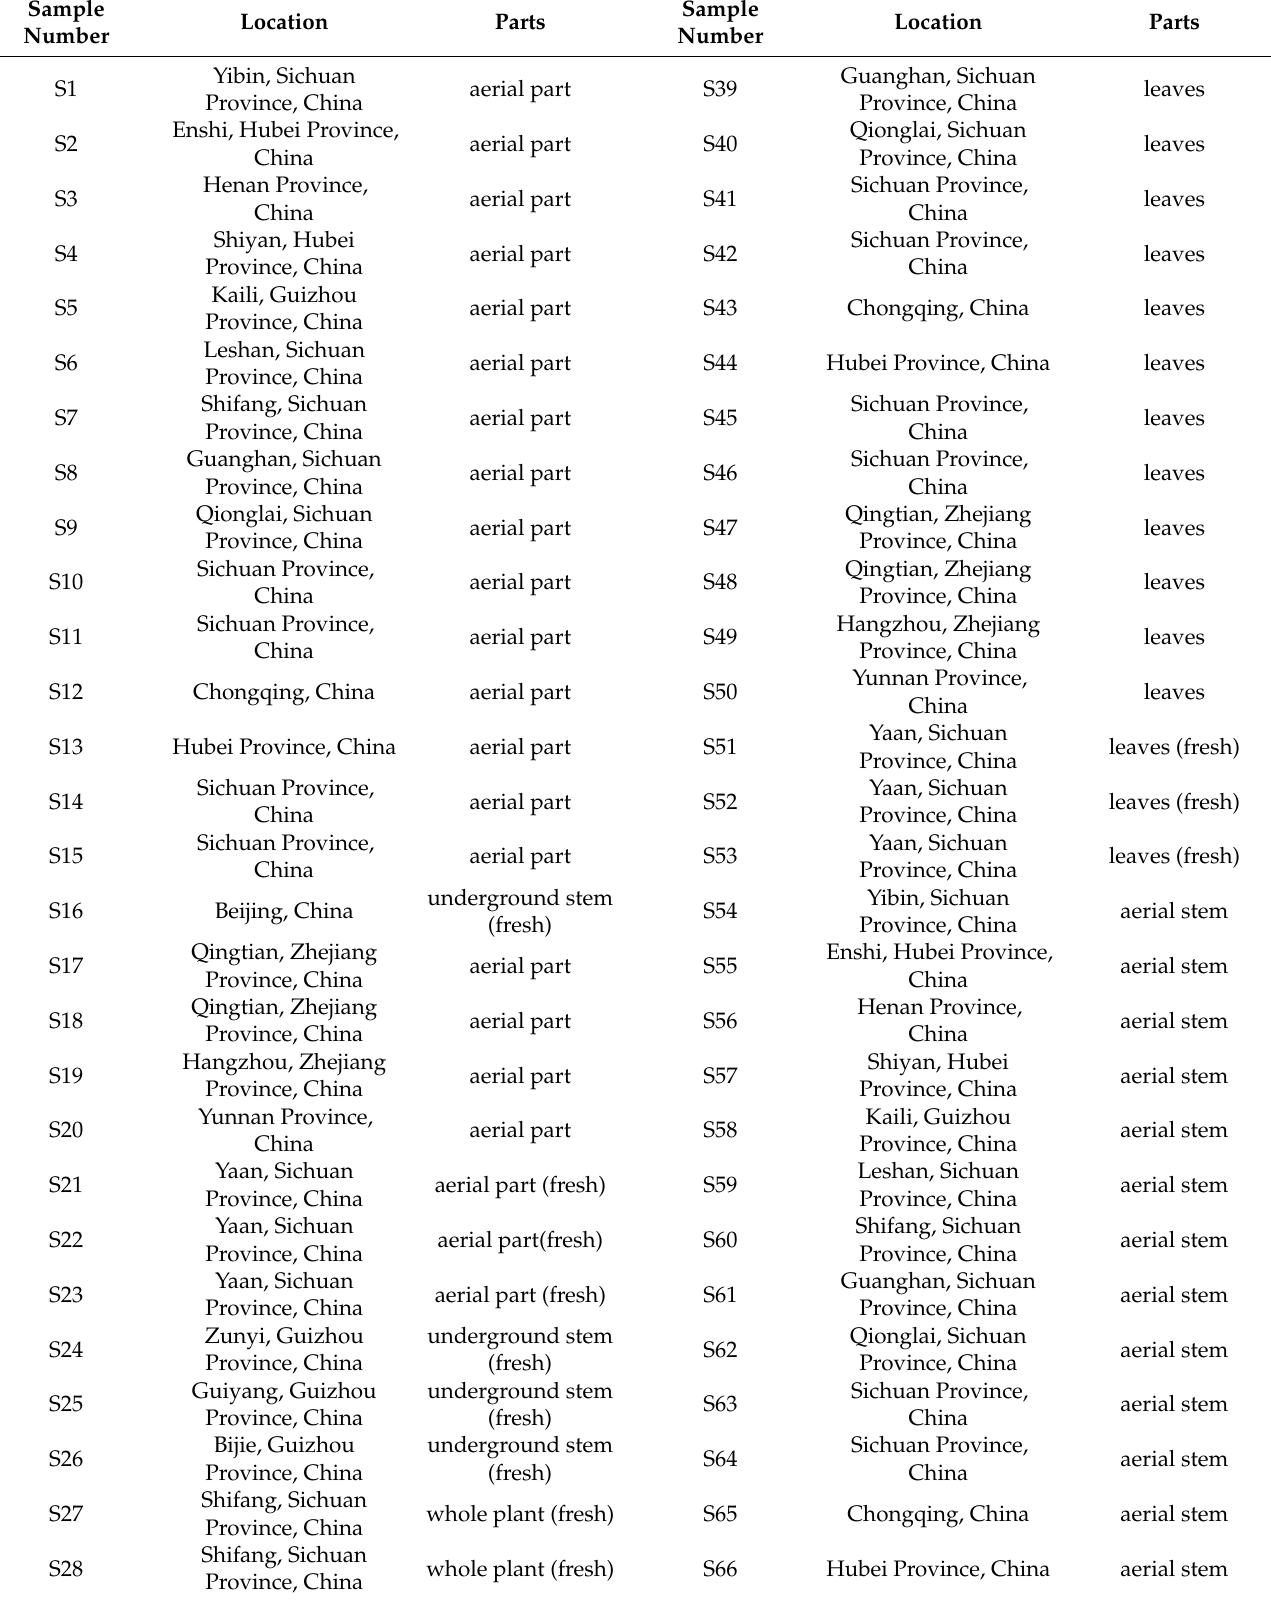
Table 3. Sample collection information for the present